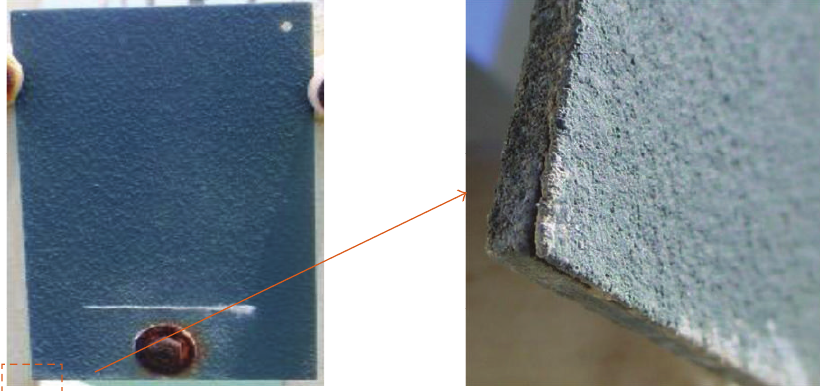
Figure 8: Thermal-sprayed coating of Zn/Al/wash primer 1 (325 μ m). Notice the flaw at the edge on the left